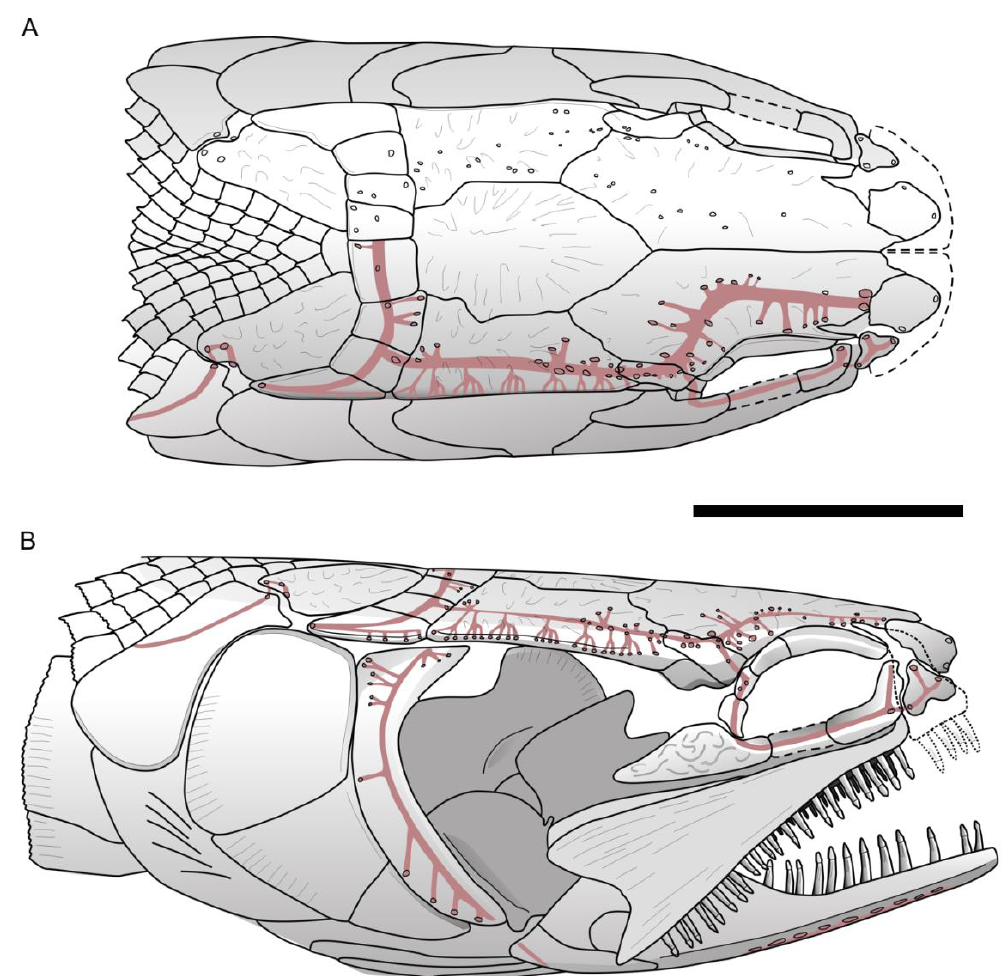
Figure 6. Skull reconstructions of a Khoratamia phattharajani gen. et sp. nov. showing the pattern of sensory canals in dorsal view ( A ) and lateral view ( B ). Scale bar: 2 cm. Paratype. NRRU-F01020024 (Figure 7), portion of a body with articulated scales, with a series of vertebral centra wedged in between both flanks of the specimen.